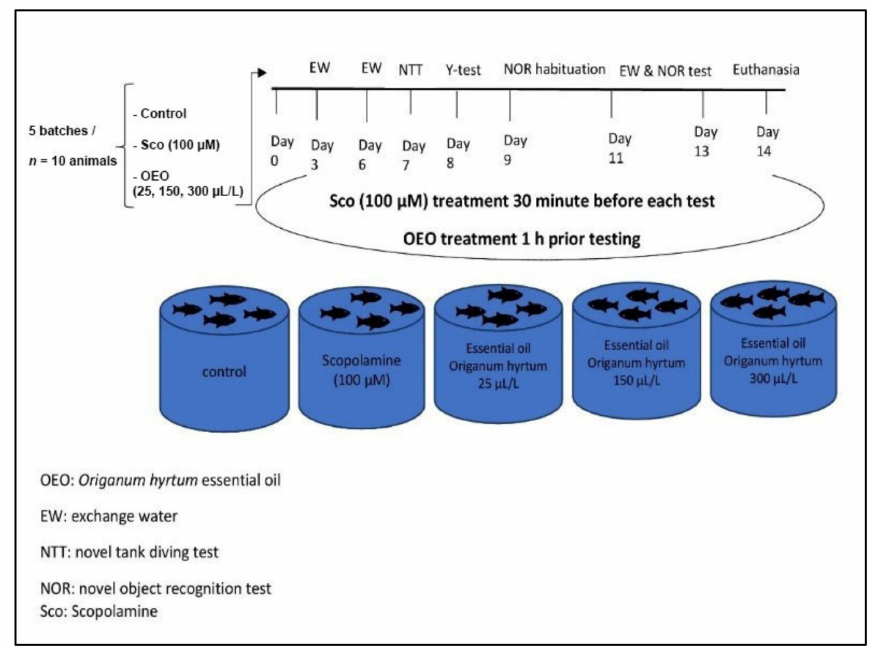
Figure 9. Experimental design for the O. vulgare ssp. hirtum essential oil administration in relation to scopolamine (100 µ M) treatment for the study of behavioral and biochemical